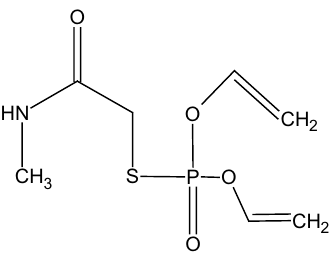
Fig. 2. Chemical structure of